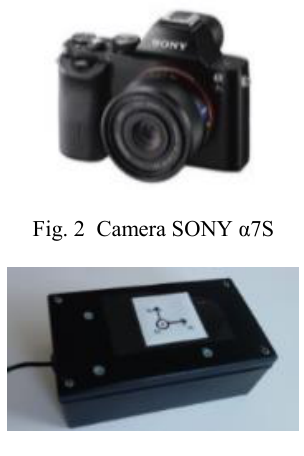
Fig. 1 Analysis flow used in this paper Fig. 3 IMU Seiko Epson